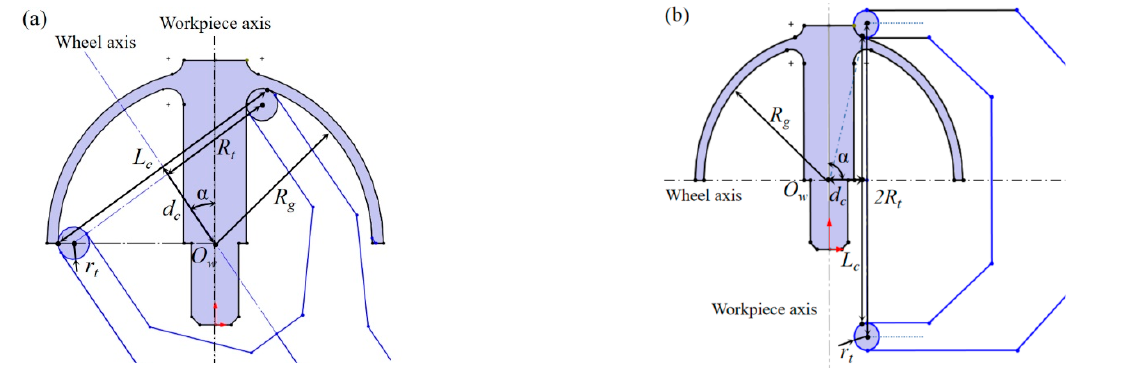
Figure 4. Tool-workpiece junction geometric model of HSR grinding: ( a ) external spherical grinding, ( b ) internal spherical grinding.